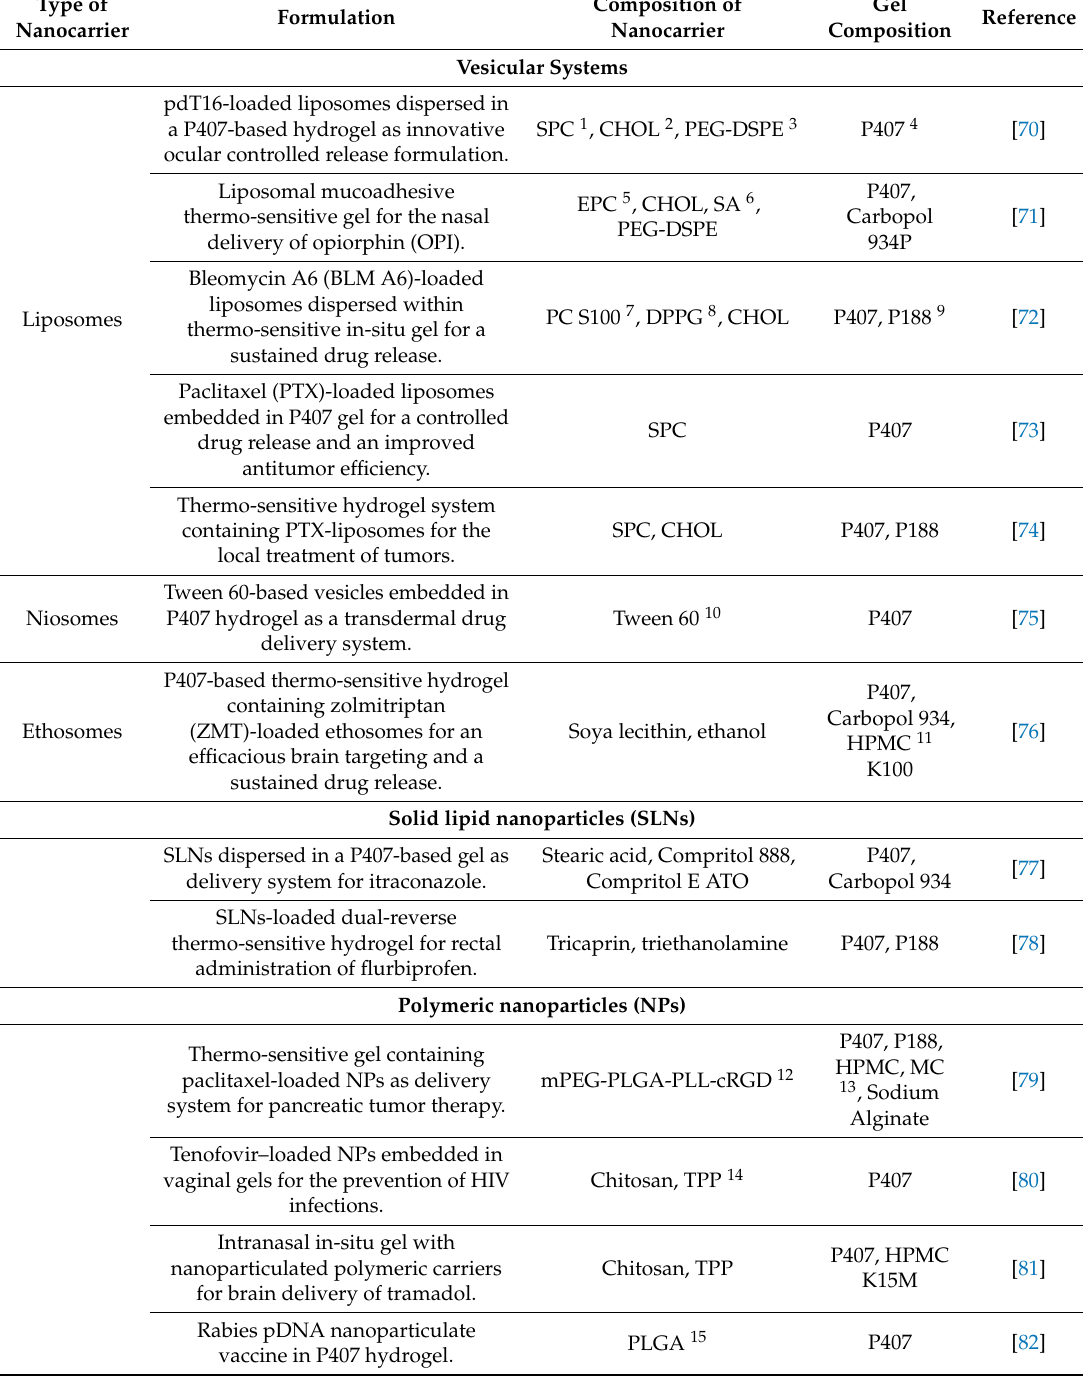
Table 1. Examples of drug-loaded biocompatible nanocarriers embedded in P407-based hydrogels. Type